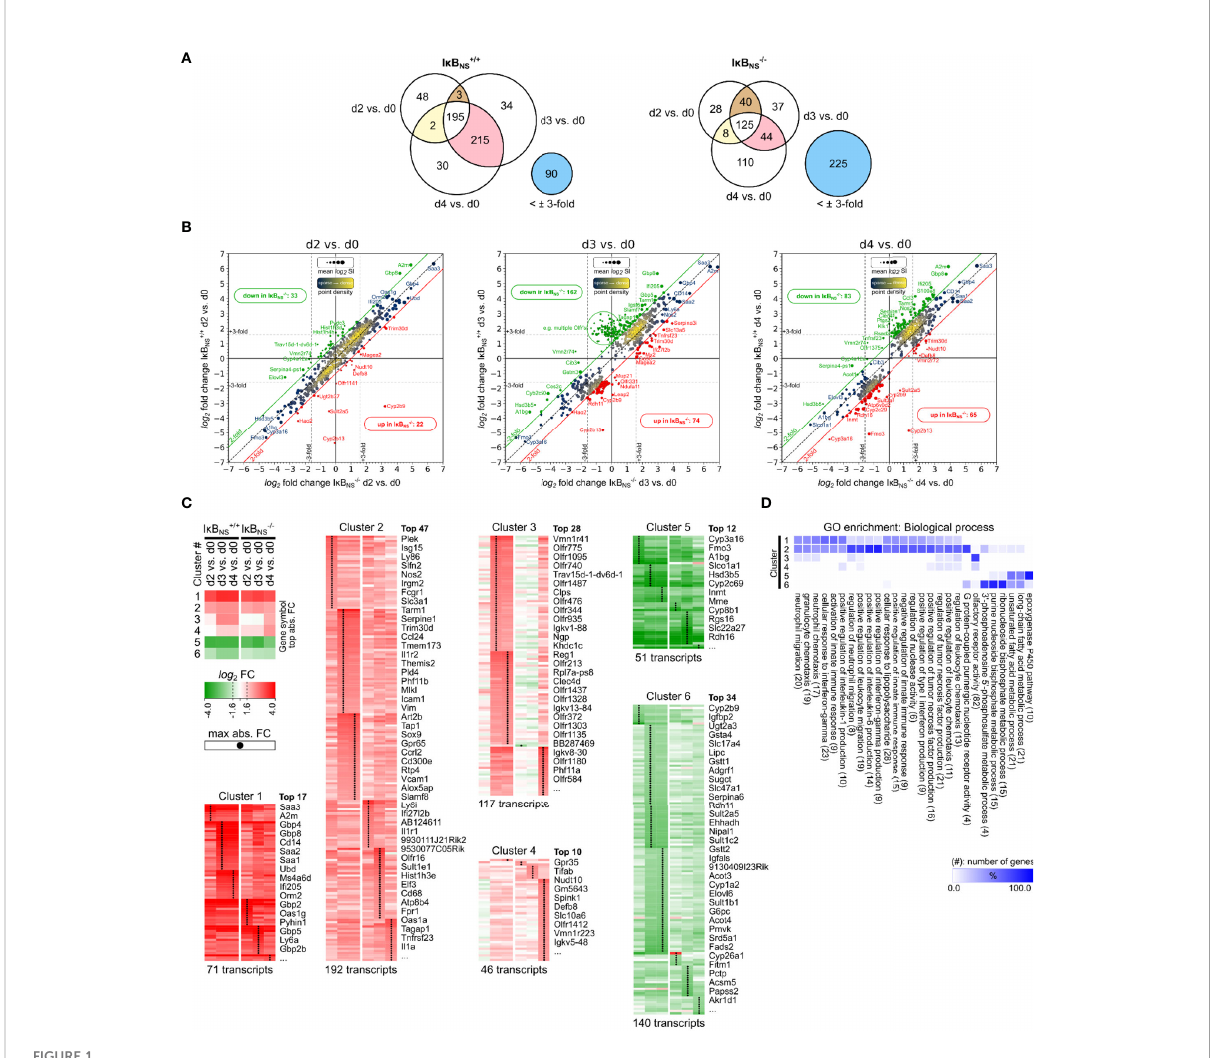
FIGURE 1 Transcriptome analysis of Listeria infected I k B NS-/- and wild type livers. WT and I k B NS-/- mice were infected with 10 5 CFU LM i.v. or left untreated (d0). Mice were sacri fi ced on day 2, 3 and 4 post infection, liver homogenates were prepared and sampled for total RNA isolation. Equal amounts of RNA from n = 3-5 mice per genotype and sampling time were pooled per experimental group and applied to Affymetrix Gene 2.0 ST microarray analysis. (A) Venn diagrams of 617 annotated transcripts differentially regulated at least ±3-fold in reference to d0 in I k B NS-/- or WT livers on d2, d3 or d4. Stated integers refer to the number of transcripts with fold change of at least ±3-fold in the indicated comparison and the extend of gene symbol overlap between them. Blue circles refer to transcripts not regulated I k B NS-/- or WT liver d2, d3, d4 comparisons, respectively. (B) log 2 /log 2 fold change scatter plots of conditions shown in a), comparing log 2 fold changes of the 617 transcripts between I k B NS -/- (x-axis) and WT livers (y-axis) per analysis day post infection. Red and green diagonal threshold lines refer to log 2 fold change differences of at least 2-fold. Framed red/green integers refer to the number of transcripts above/below this threshold in I k B NS-/- livers. Dashed vertical/horizontal threshold lines refer to the fold change critirion ( ± 3-fold) applied in the comparisons shown in a). Gene symbols of selected transcripts are stated (red: up in I k B NS-/- , green: down in I k B NS-/- ). (C) log 2 fold changes of conditions in a) for the 617 transcripts were color coded and k-means clustered (k = 6). Shown gene symbols in each cluster are ranked by average absolute fold change and only the top n symbols are stated. Total numbers of transcripts per cluster are stated below. Black points in clusters indicate condition with maximal absolute fold change per transcript. Top left: Legend with cluster summary, representing average log 2 fold changes per condition and cluster. (D) Gene ontology (GO) enrichment analysis for GO category “ Biological process ” showing terms with FDR < 0.05 and GO level ≥ 8. Percent of genes falling into clusters shown in c) in reference to the total number of mapped genes within overrepresented GO terms were calculated, hierarchically sorted and color coded. Total number of mapped genes per GO term is stated in